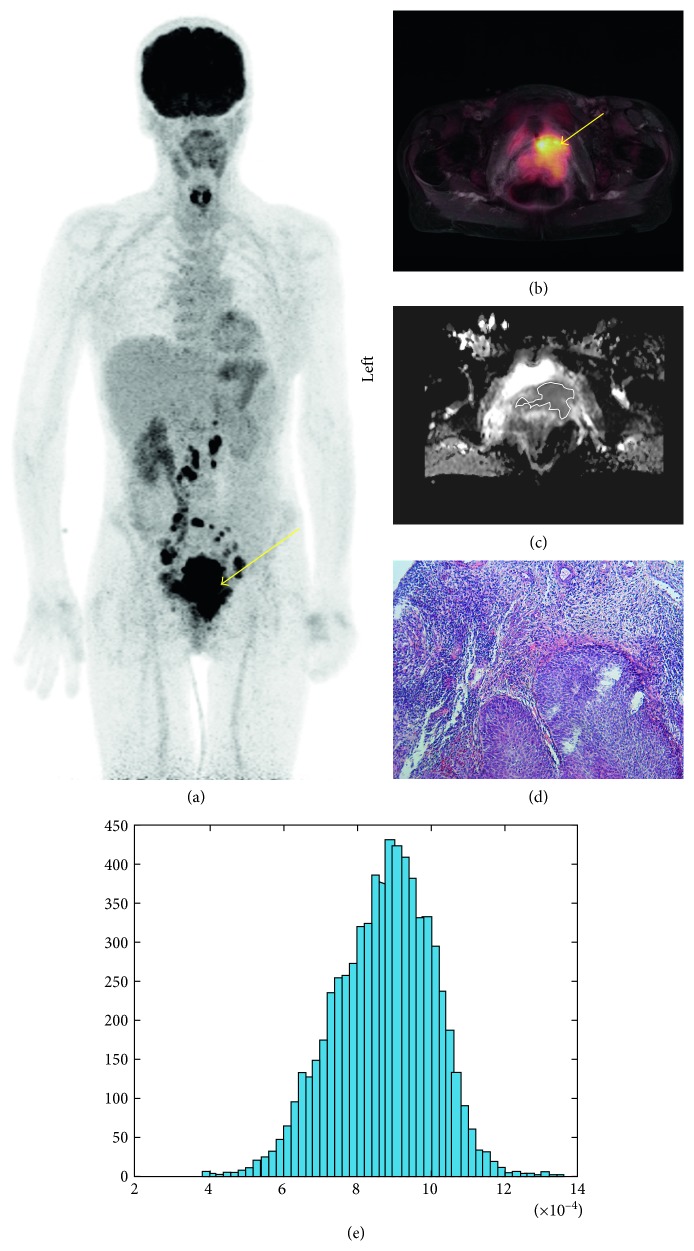
Imaging and histopathological findings in a case of cervical cancer. (a) 18F-FDG-PET of a 57-year-old woman with locally advanced cervical cancer (arrow). (b) Fused 18F-FDG-PET/MRI image demonstration of the metabolic active uterine cervical cancer (arrow). Calculated 18F-FDG-PET parameters are as follows: SUVmax = 8.77, SUVmean = 4.66, SUV median = 4.32, TLG = 92.91, and MTV = 19.96. (c) ADC map of the tumor with a ROI. (e) ADC histogram. The histogram analysis parameters (×10−3 mm2·s−1) are as follows: ADCmin = 0.36, ADCmean = 0.87, ADCmax = 1.36, p10 = 0.7, p25 = 0.78, p75 = 0.96, p90 = 1.03, median = 0.88, and mode = 0.93. Histogram-based characteristics are as follows: kurtosis = 2.96, skewness = −028, and entropy = 4.72. (d) Histopathological examination (hematoxylin and eosin-stained specimen) after tumor biopsy reveals a G2 cervical cancer.